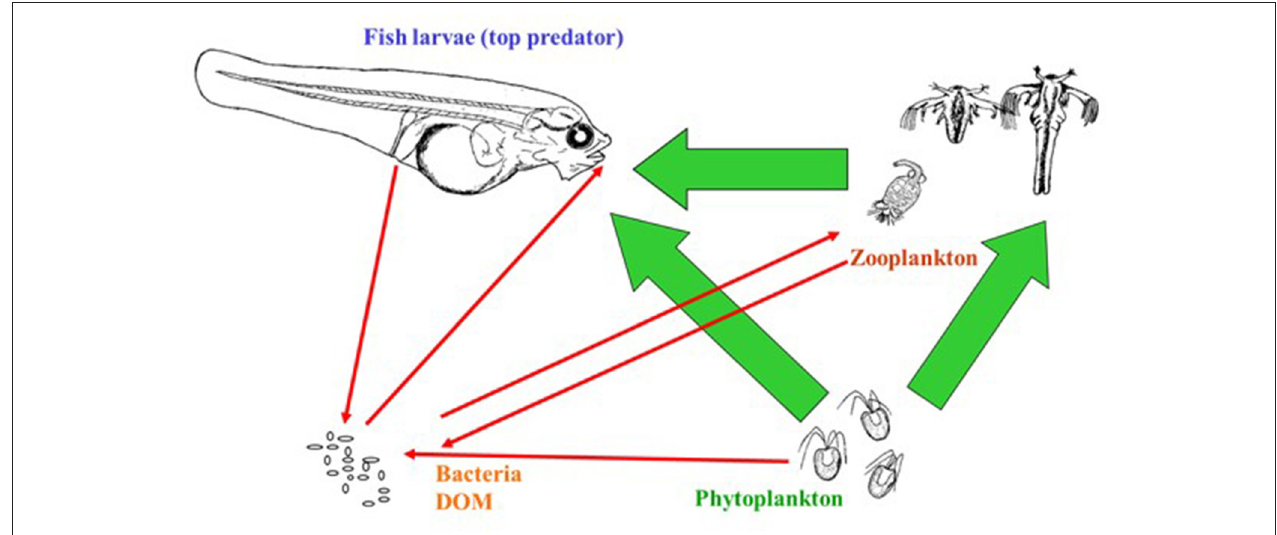
FIGURE 1 | First feeding of larvae in a complex food web. Arrows indicate direction of effects in the direction of the arrow. Interactions between dissolved organic matter (DOM) and bacteria, and bacteria-bacteria interactions are not indicated. In addition to interactions ongoing within the rearing tank, various inputs and losses from the tank also affect the microbe-dominated food